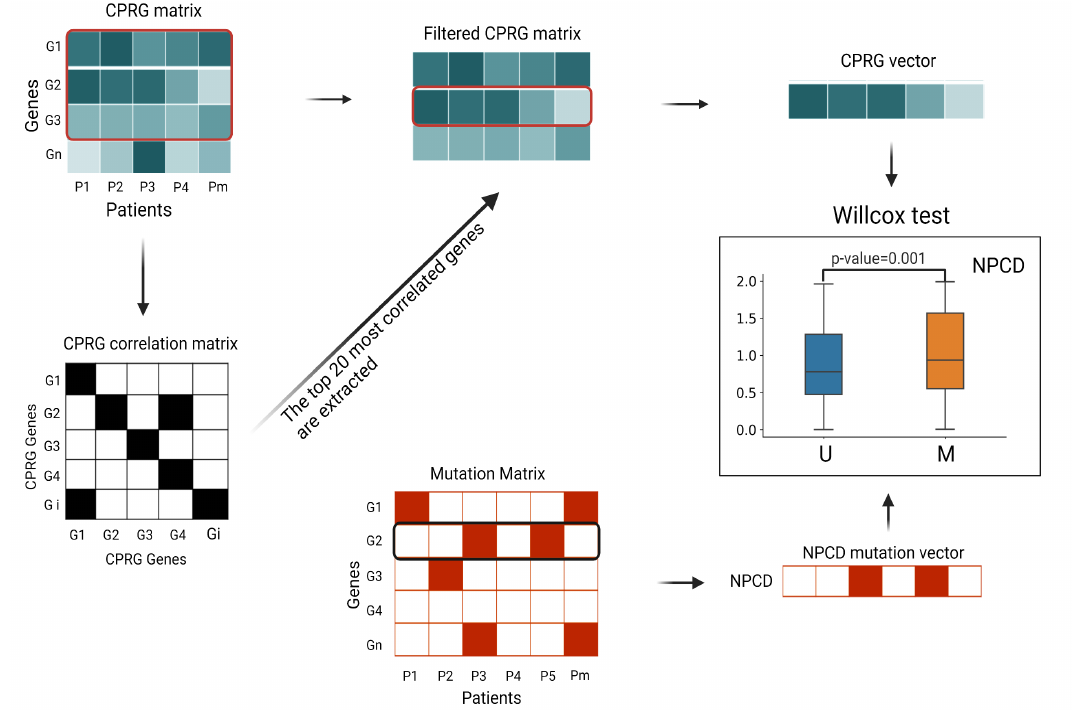
Figure 7. Flow chart of DNA replication function correlation test. (1) We extracted the fraction of all CPRGs from the gene expression matrix ∈ R 20500 × n (n is the number of samples) of each tumor type and created the CPRG matrix ∈ R 160 × n . (2) According to the Spearman correlation coefficient threshold, we generated CPRG correlation Matrix ∈ R 160 × 160 (symmetric matrix). (3) We selected the top 20 genes with the highest correlation in the CPRG matrix and extracted the top 20 genes from the CPRG matrix to produce the Filtered CPRG matrix ∈ R 20 × n . (4) The mean expression level of each CPRG in the filtered CPRG matrix was used to calculate the linear regression parameters for each sample, as the CPRG vector for the sample. The CPRG vectors were divided into mutation/nonmutation vectors according to the mutation matrix, and the Wilcoxon test was performed on the distributions of these two vectors to compute the p -values. The box plots are drawn for each NPCD by the two sample-population distributions (Figure